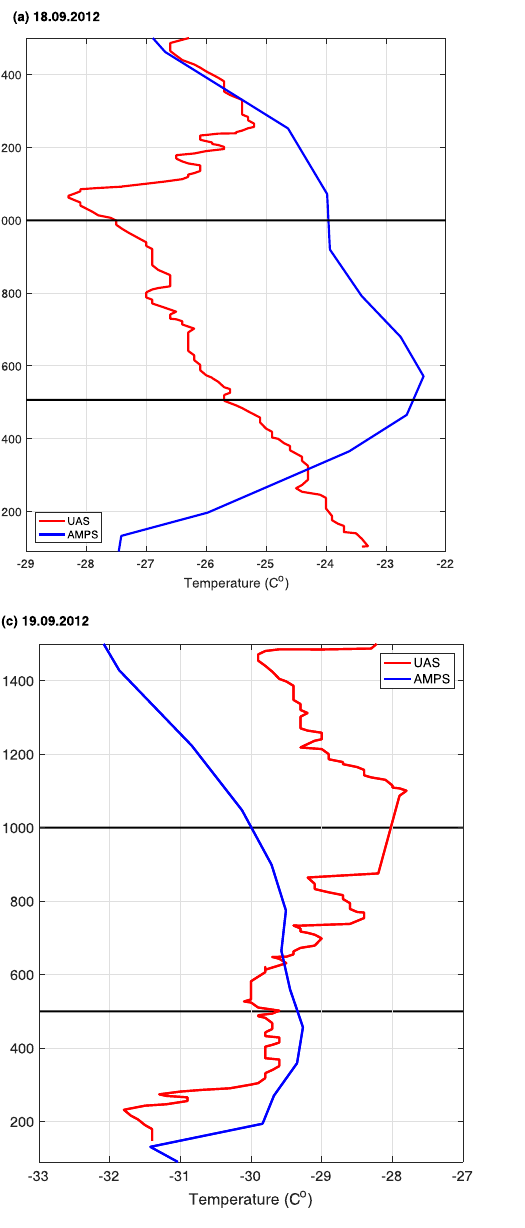
Figure 13. Exemplary profiles from UAS Aerosonde observations and AMPS model results. ( a , b ) Profile nr. 2, 18.09.2012. ( c , d ) Profile nr. 4,